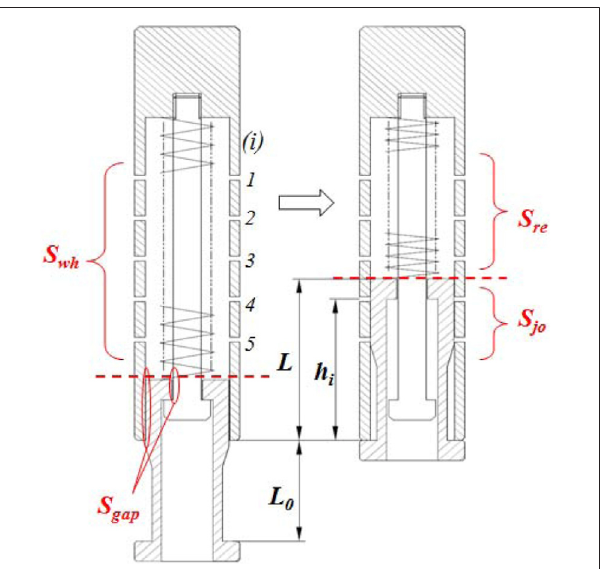
FIGURE13| IllustrationoftheCorrespondingDe fi nitionoftheEquivalent fl ow